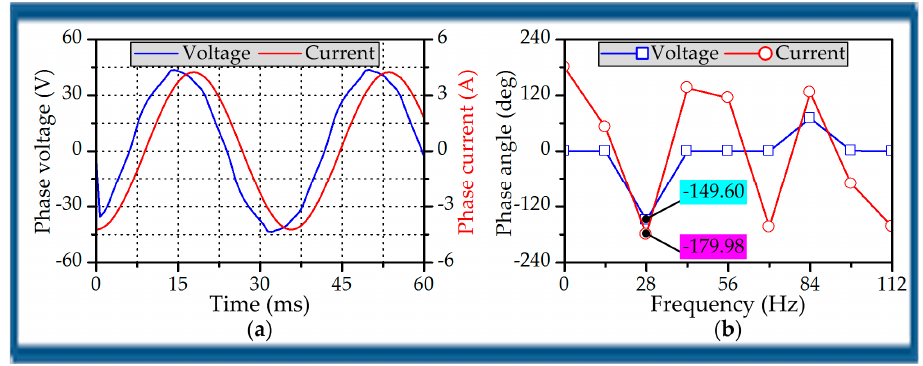
Figure 13. Proposed DPME machine: ( a ) Phase voltage and phase current waveforms; ( b ) Corresponding phase angle calculated by FFT.